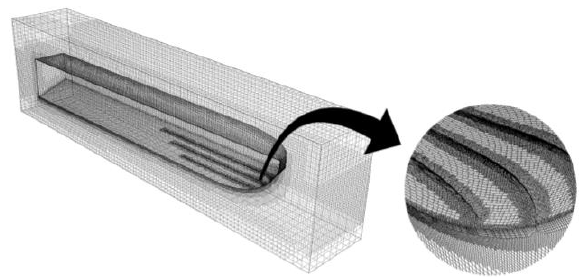
Figure 5. The concentration of mesh density on the strip profile.